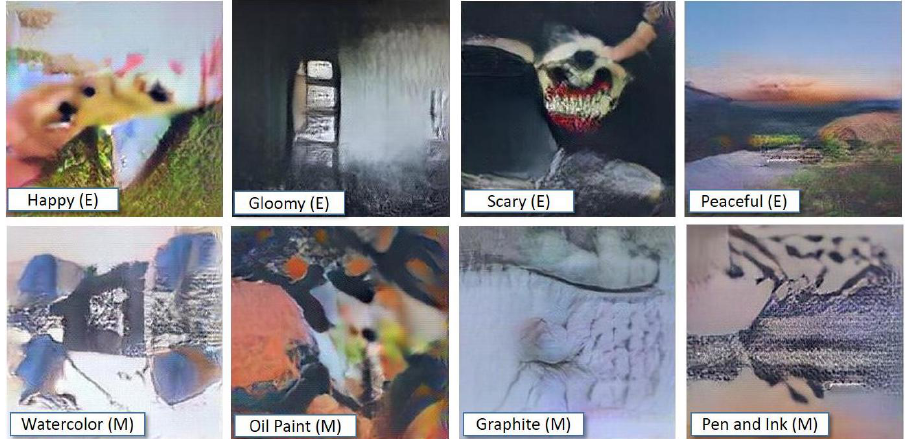
Figure 9. Images that we generated using a neural network trained on different subsets of a database of artistic imagery (Wilber et al. 2017). Each one is meant to typify a single stylistic category or a medium, though the biases of the convolutional neural network architecture are also